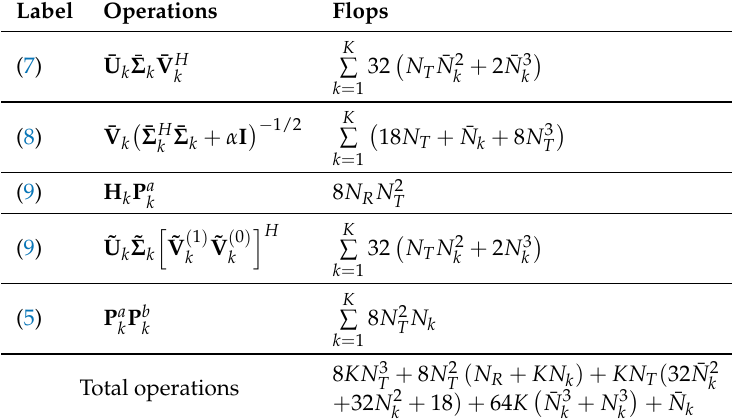
Table 2. Computational complexity of each operation for regularized block diagonalization (RBD) at